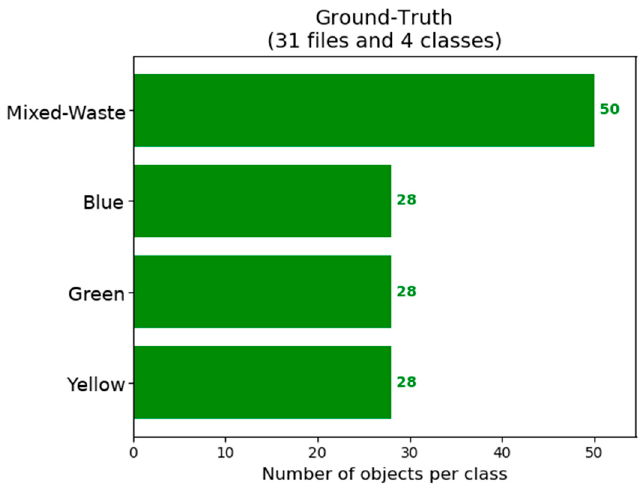
Figure 10. The number of object instances per class the and number of images in the test set.